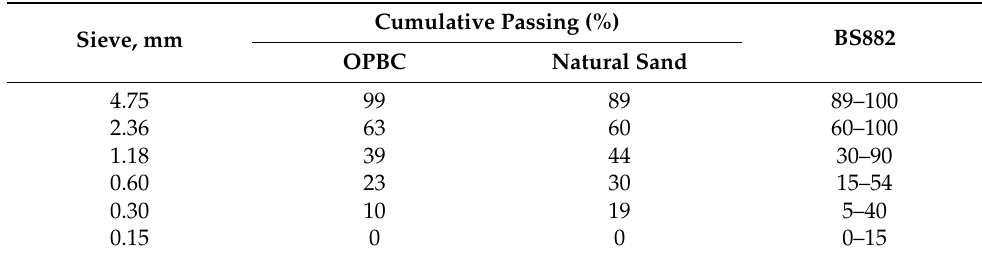
Table 3. Sieve analysis of OPBC and natural sand with